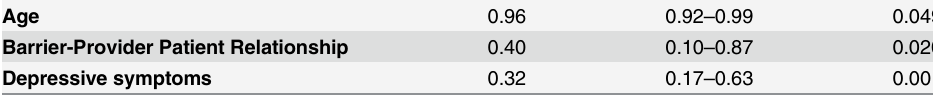
Table 3. Multivariable Logistic Regression Model for Treatment